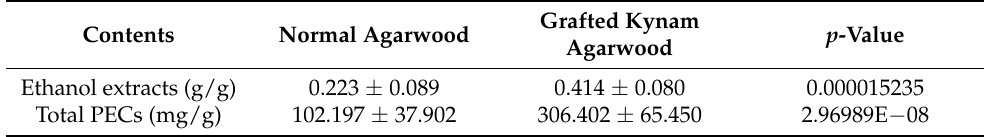
Figure 2. Content of agarwood ethanol extracts ( a ) and total PECs ( b ). The ethanol-soluble extract content was determined according to the procedures of the Chinese Pharmacopoeia. The total PEC content was measured at 254 nm with agarotetrol as the standard. Table 1. Average content of the agarwood ethanol extract and the total PECs from 12 batches of GKA and 12 batches of normal agarwood. p values indicate significant differences between the tested extracts according to Tukey’s test.